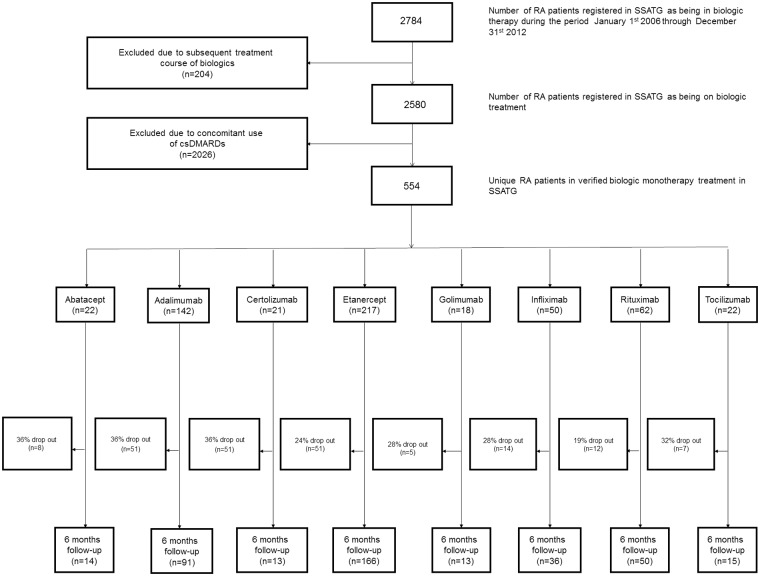
Study sample (flow diagram).